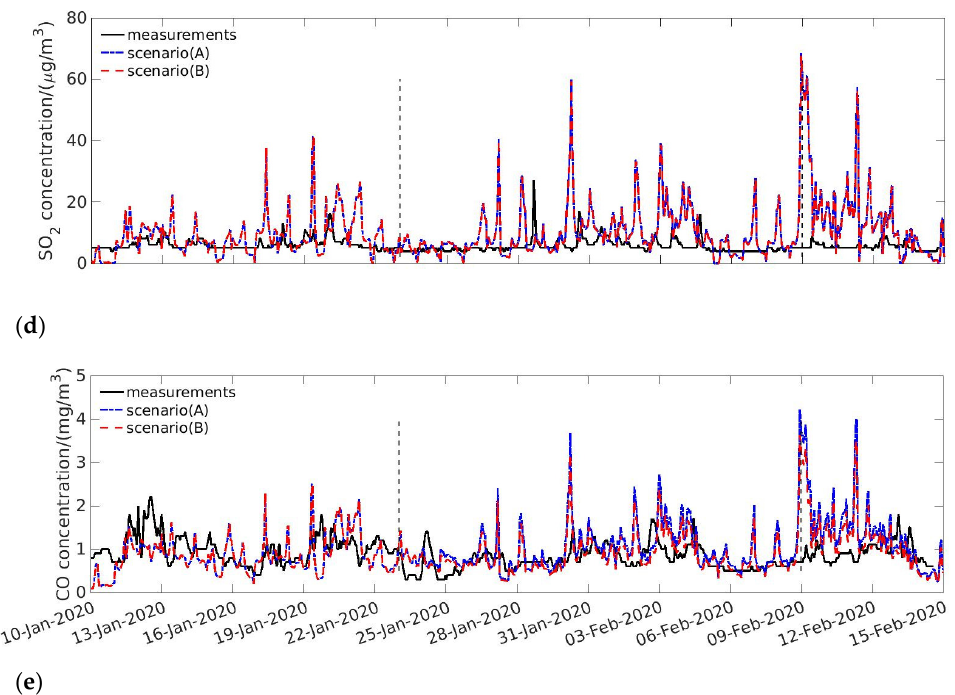
Figure 5 . Pollutant concentrations influenced by the transportation emission. Each panel shows the comparison of observations and simulation results of scenario ( A ) and ( B ) for ( a ) PM 2.5 , ( b ) PM 10 , ( c ) NO 2 , ( d ) SO 2 , and ( e ) CO .